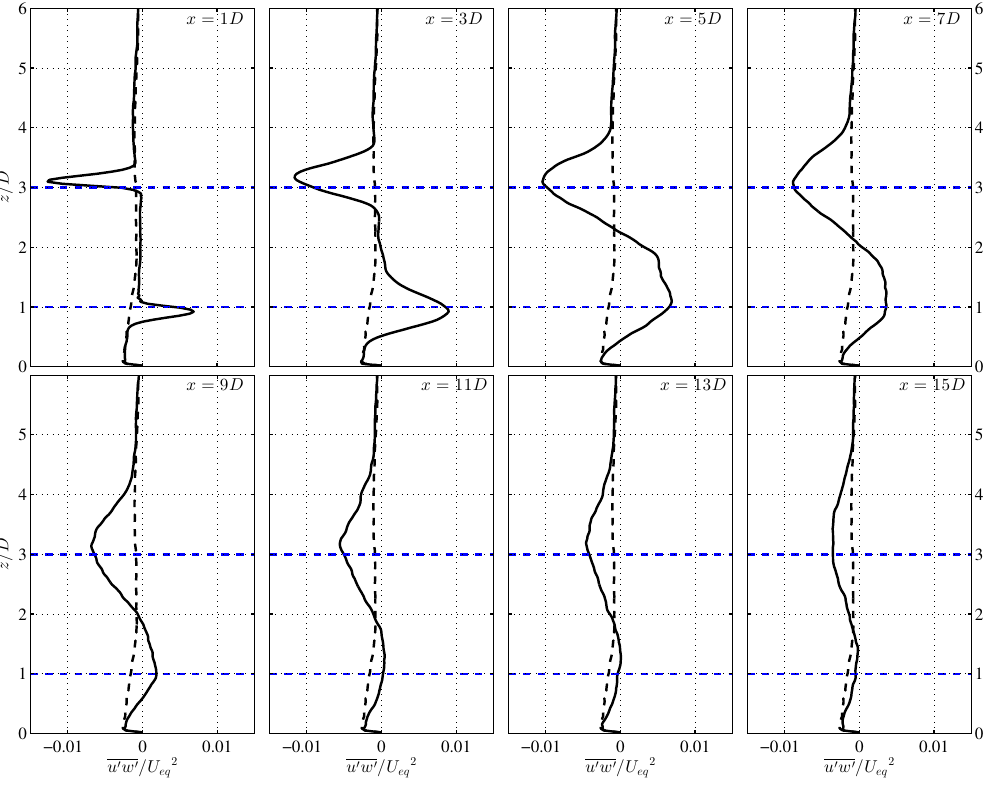
Figure 20. Vertical profiles of the normalized vertical turbulent flux ( u (cid:48) w (cid:48) / U eq 2 ) in the x - z plane going through the center of the turbine at different downstream positions. The black dashed line represents the inflow profile, and the blue horizontal dashed lines show the extent of the